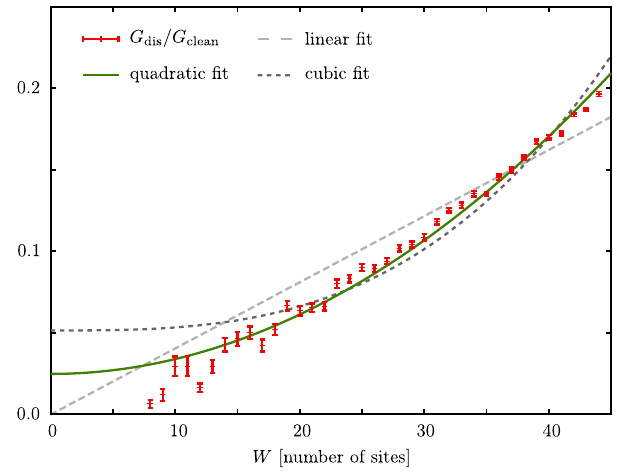
FIG. 11. Ratio of conductance of a disordered W × W × 20 system to the conductance of the clean system averaged over 100 disorder realizations. The green line is the best fit to the data — parabolic; grey curves show the failure of the linear [with non- negative G ð 0 Þ ] and cubic